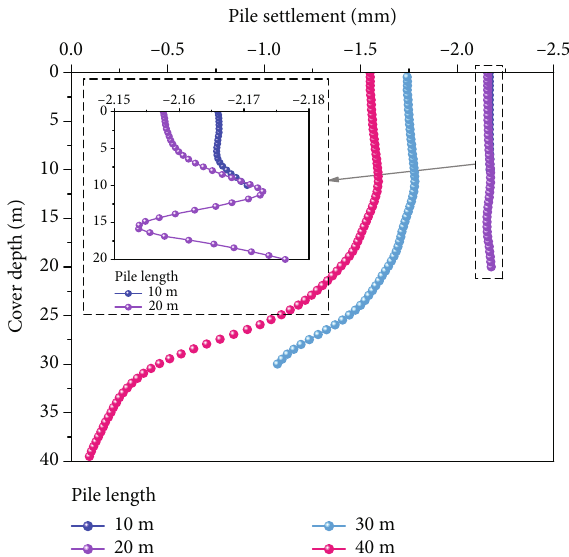
Figure 20: Variation of the pile settlement with the cover depth for di ff erent pile